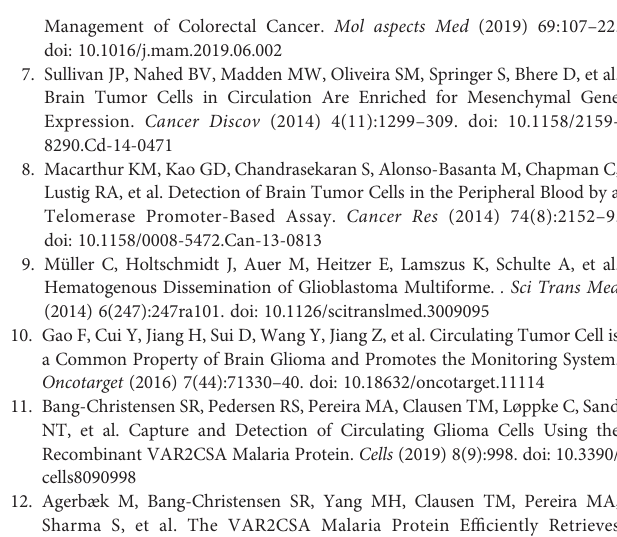
Supplementary Figure 1 | Detection of smaller CTC in patients with glioma. No signi fi cant difference was observed in detection level of smaller CTC in patients from WHO grade 1 to 4 ( p >